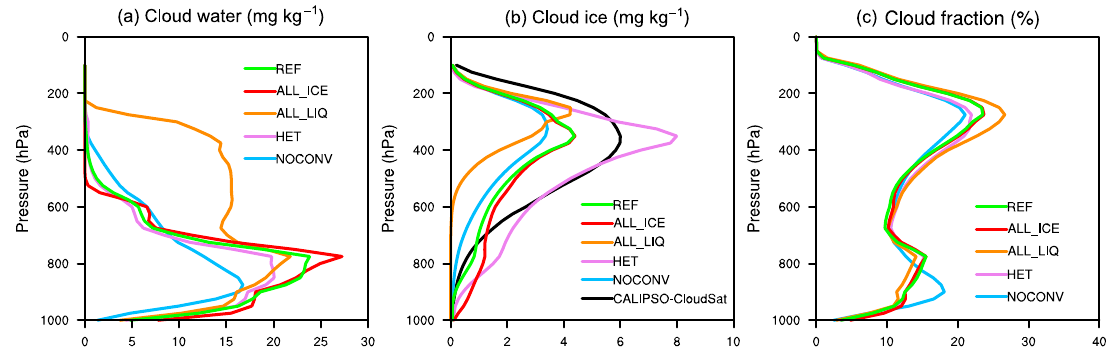
Figure 2. Annual global mean cloud liquid water content (a) , ice water content (b) in milligrams per kilogram, and cloud cover (c) in percent as a function of pressure in hectopascals from the various sensitivity atmosphere-only present-day simulations for the years 2003–2012 described in Table 1 and observations of the ice water content from CALIPSO-CloudSat for the years 2006–2010 by Li et al. (2012).